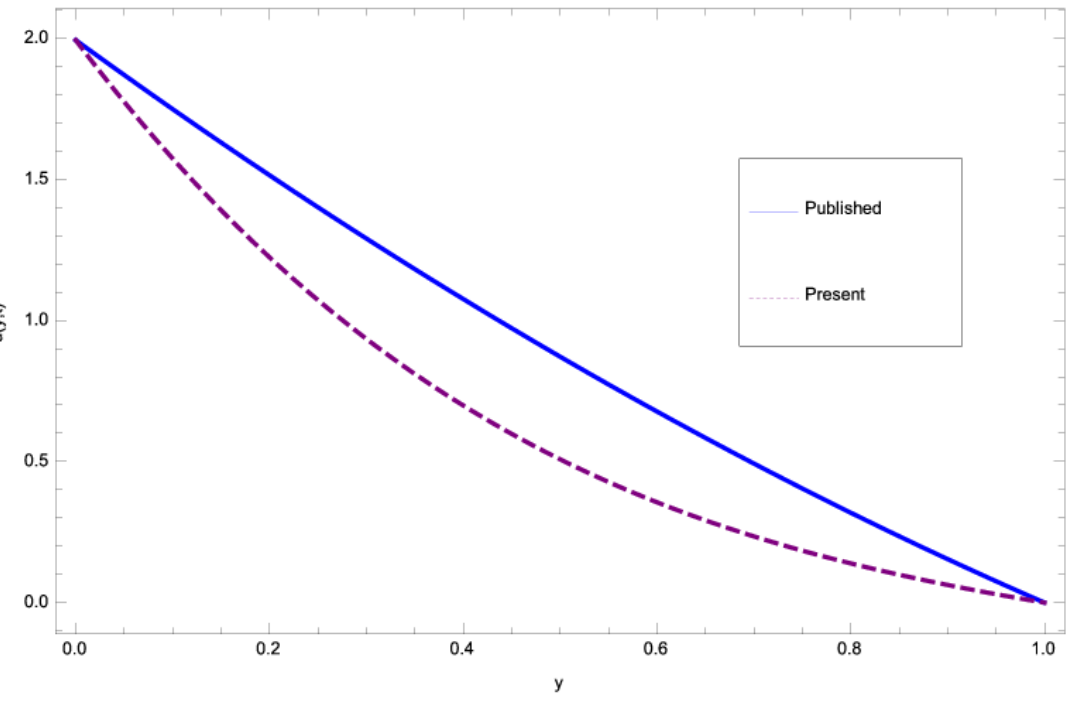
Figure 12. The comparison of the velocity profile of the present work and published work [18], when. α = 0.5; W e = 0.3; S t = m = 1; M = λ = 0; a = ξ = 1; ω = 0.3; t =